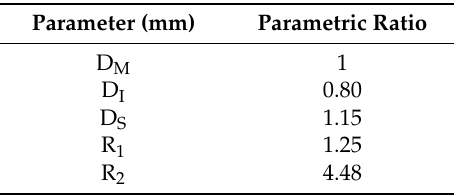
Table 3. Constants which relate the parameters of the handle to D M